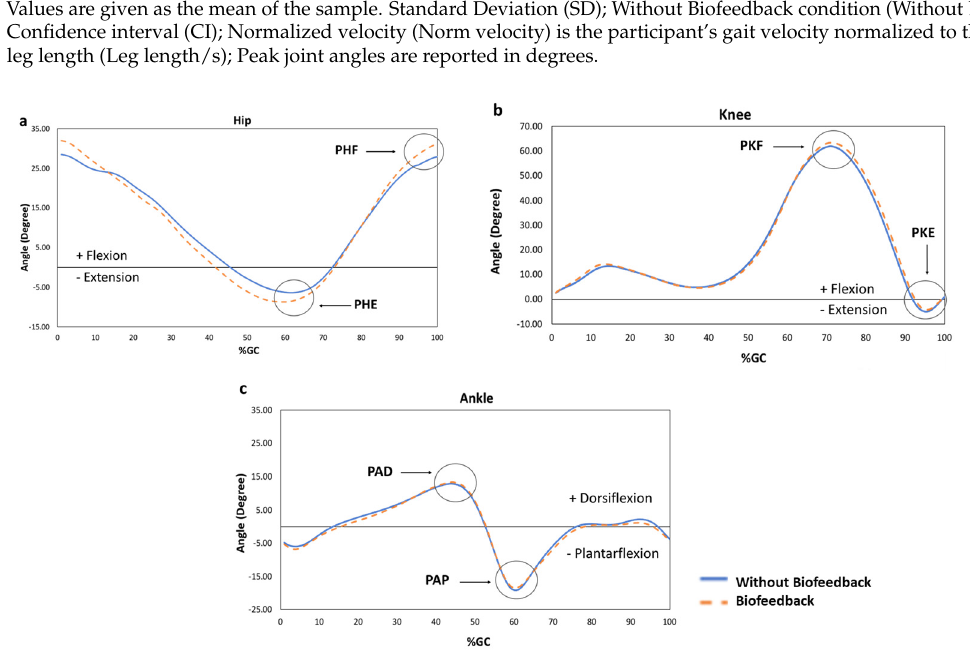
Figure 3. Range of motion of ( a ) hip, ( b ) knee, ( c ) ankle during the gait cycle of the dominant and non-dominant limbs, respectively, during Without Biofeedback and Biofeedback conditions. Positive values represent flexion, negative values extension. PHF, PHE, PKF, PKE = Peak hip and knee flexion and extension, respectively; PAD and PAP = Peak ankle dorsiflexion and plantarflexion. Data represents the average behavior of all participants.